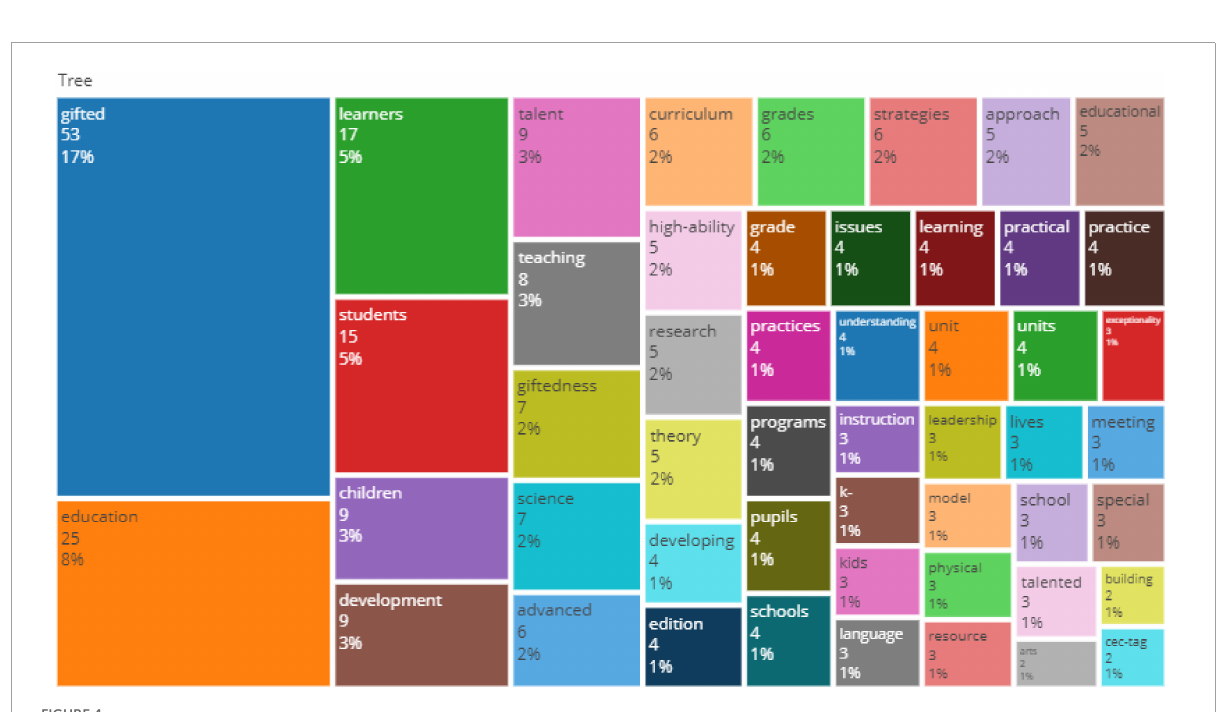
FIGURE4 Treemap of word frequency in